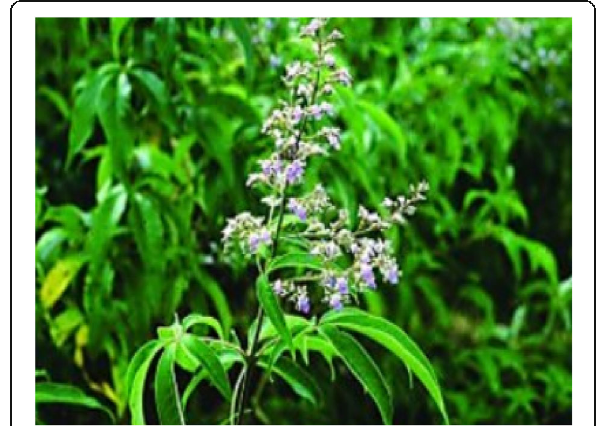
Fig. 1 Photograph of V. negundo plant leaves with purple